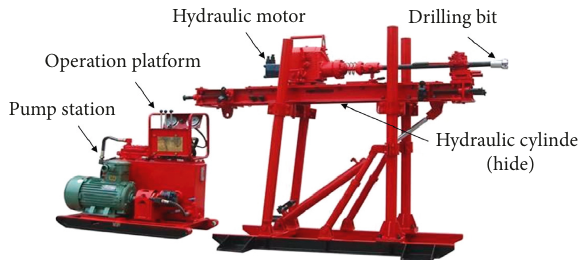
Figure 1: Full hydro drilling machine.